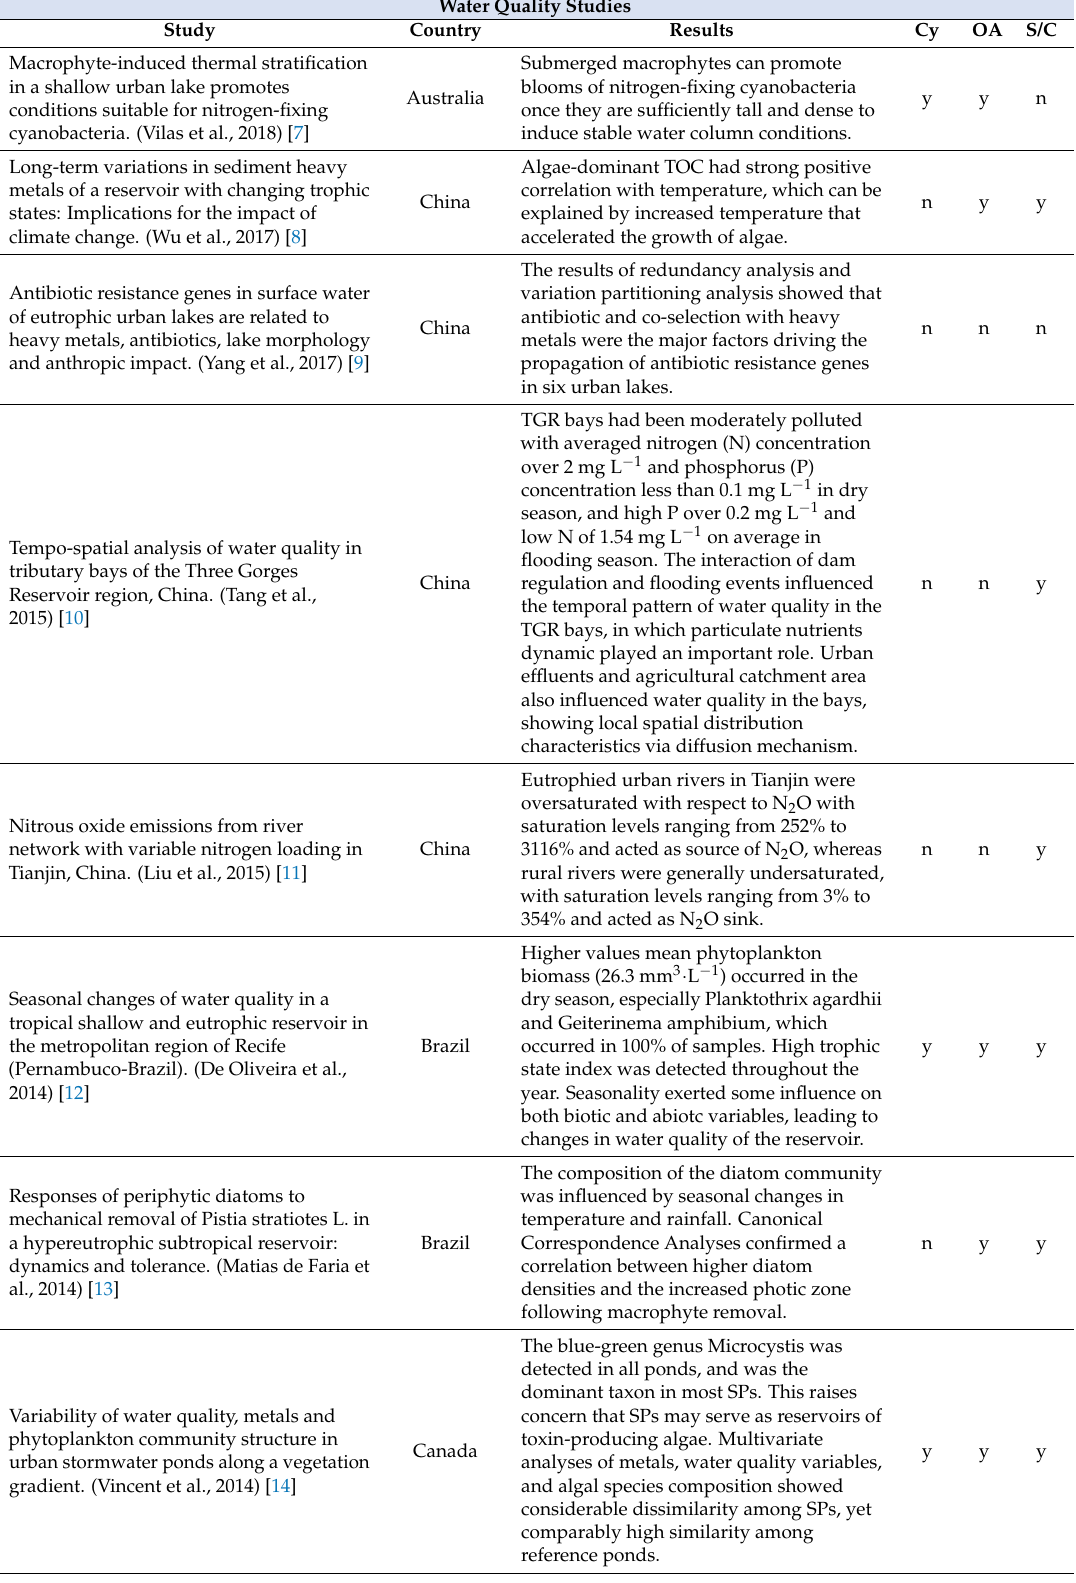
Table 1. Valid results of mapping literature review on “urban” and “eutrophic”